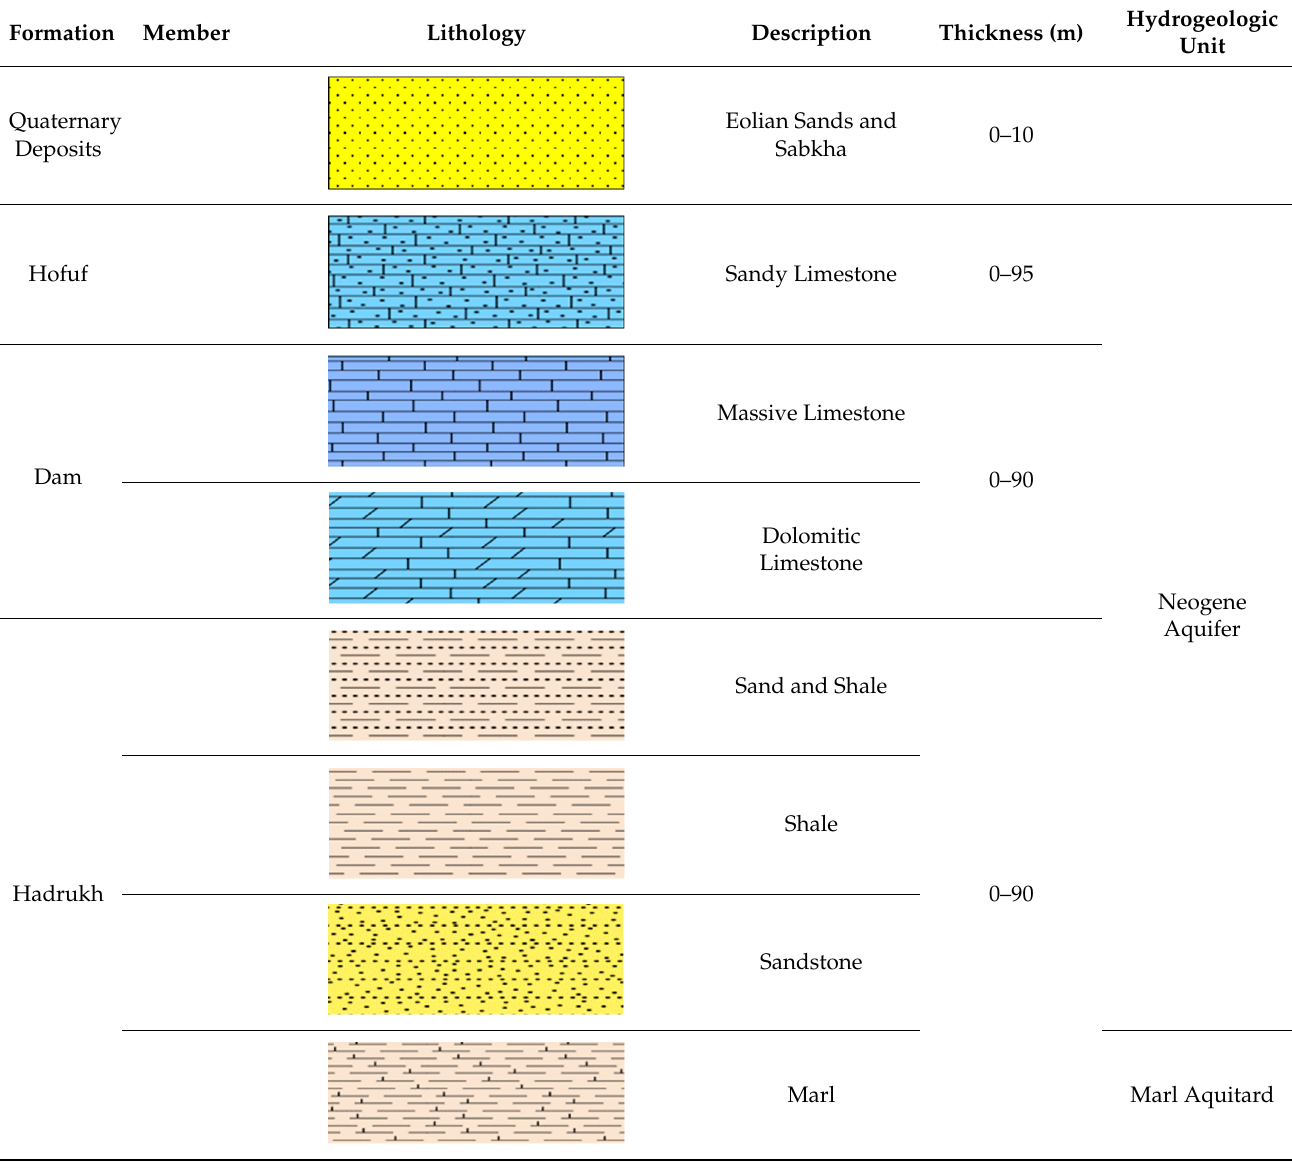
Table 1. Lithological rock units and associated hydrogeological units in the eastern coastal region of Saudi Arabia.